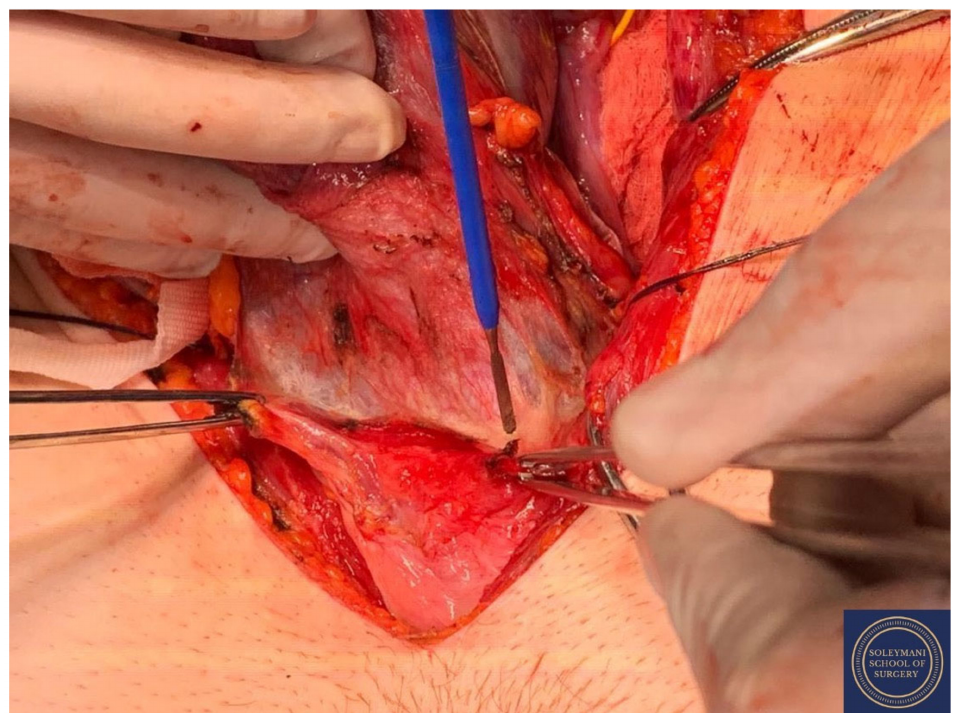
Figure 9. Incision of the peritoneum of the vescicouterine pouch with complete mobilization of the bladder away from the anterior cervix and the proximal vagina.